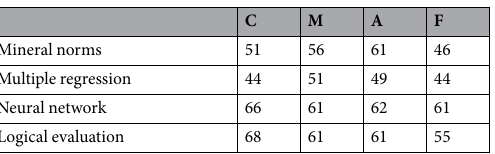
Table 3. Quality of prediction of mineral indexes by bulk-rock chemistry, testing set. Percent of